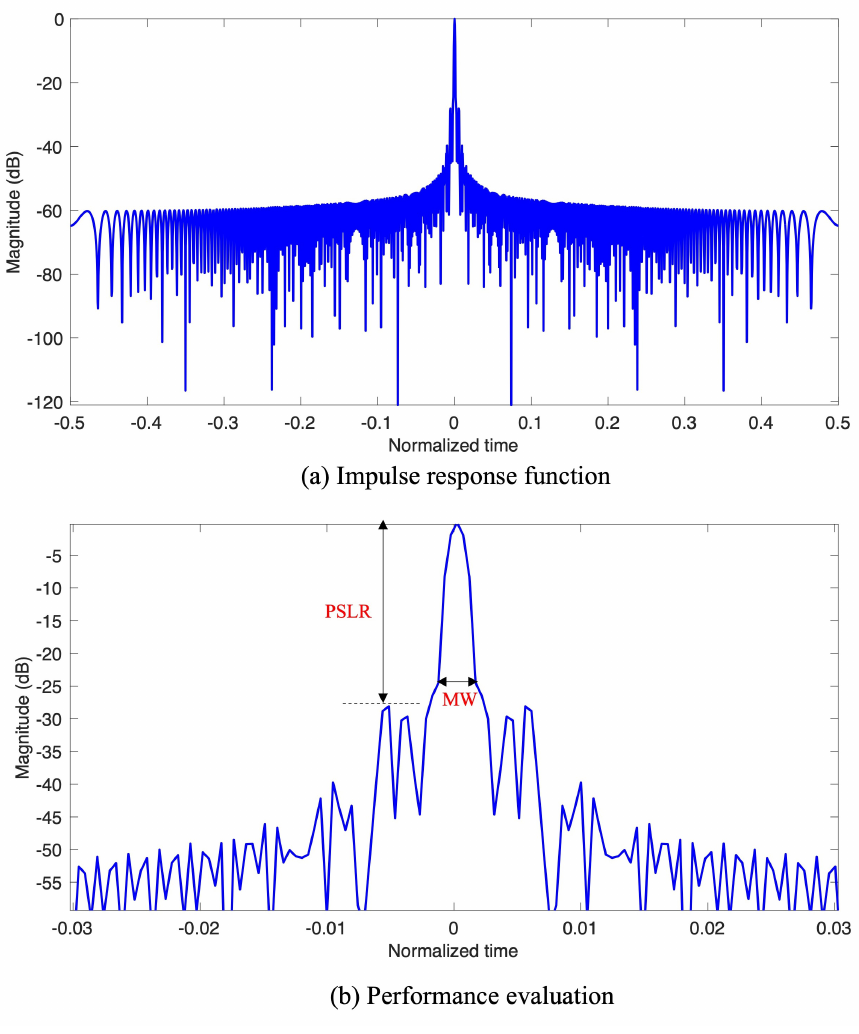
Figure 3. Signal performance